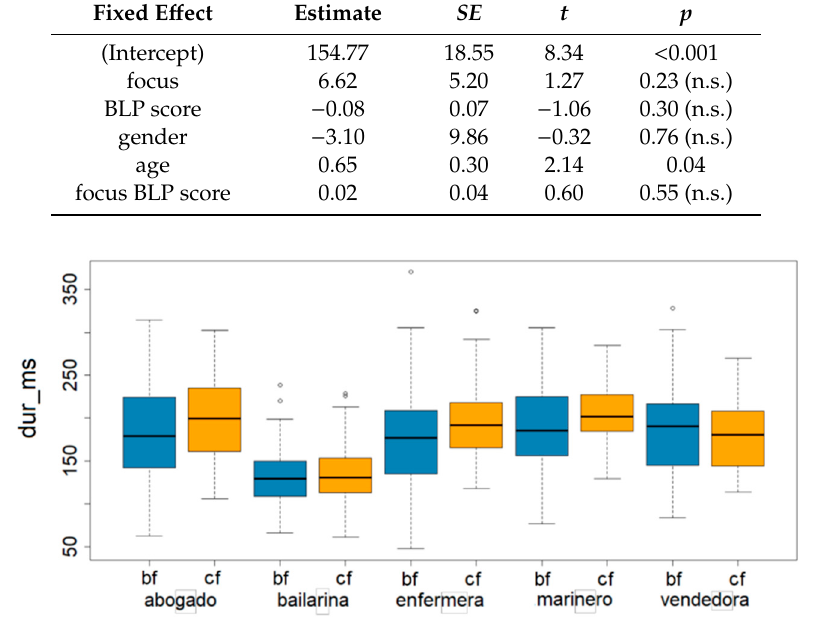
Figure 4. Duration (in ms) of the stressed syllables of the target words in subject position in broad focus (“bf”) and contrastive focus (“cf”) conditions.